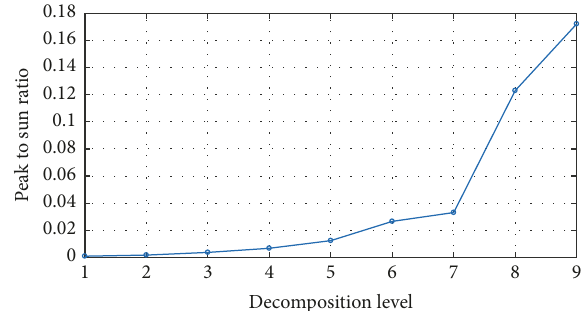
Figure 6: The peak-to-sum ratio of the wavelet detail coefficient for S11 real part.